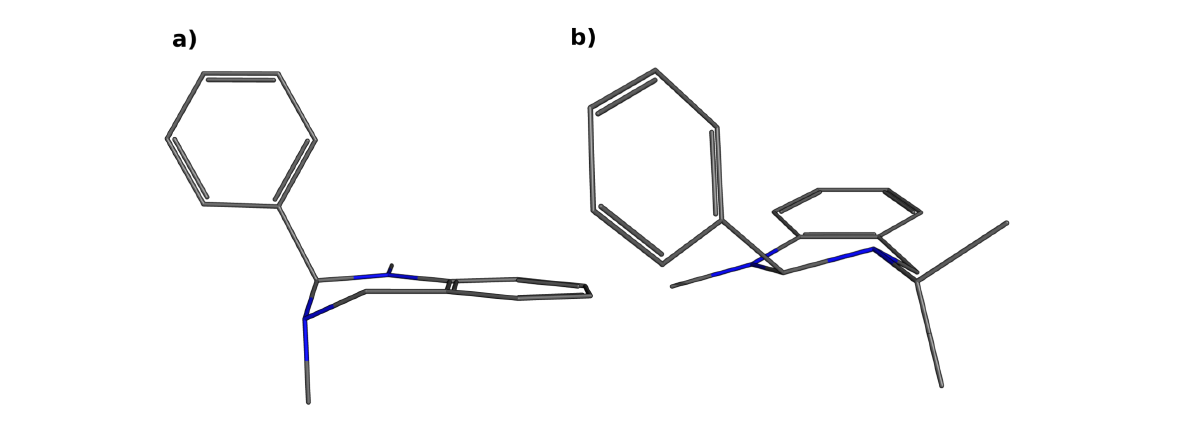
Figure 7: Minimum energy conformers in their neutral form with (a) an axial orientation of the phenyl system exemplarily shown for compound 8a and (b) an equatorial orientation of the phenyl substituent exemplarily shown for 9b .